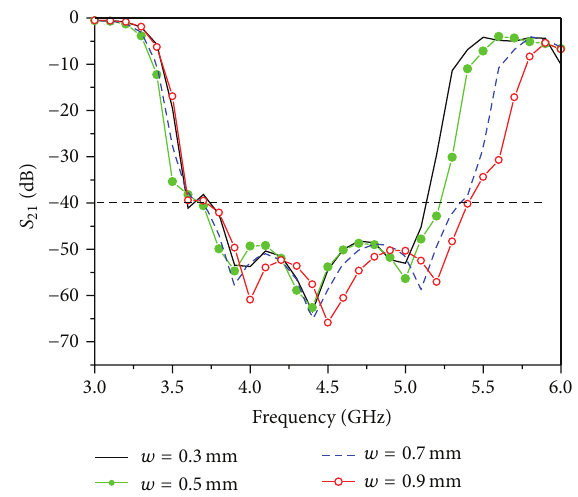
fringe equivalent capacitance with the pinwheel-shaped slots increased